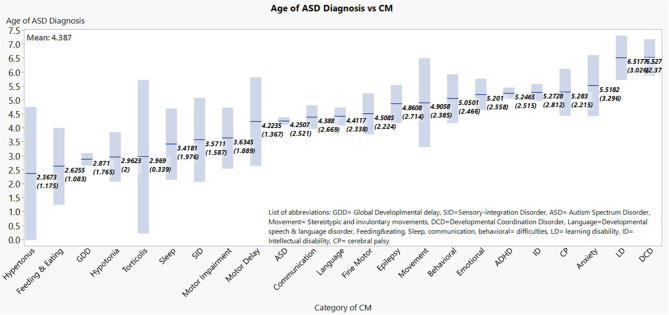
Mean age of ASD diagnosis age by respective comorbitidy sub-group are shown in ascending order, with their respective 95% confidence levels. *The number of children in the graph is higher than the total number of children with ASD since each child may get more than one diagnosis.